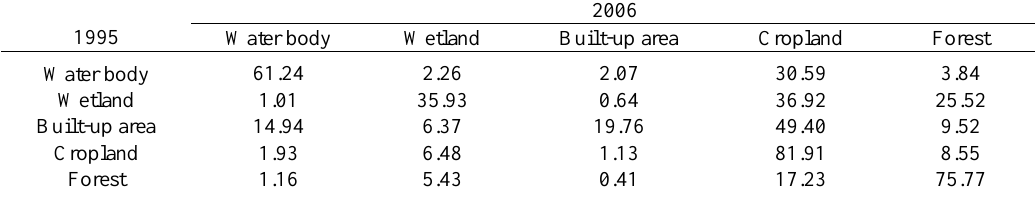
Table 1. Land cover transfer matrix of Dongting Lake from 1995 to 2006(%)